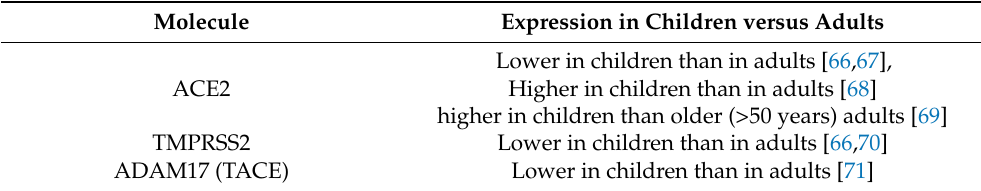
Figure 2. Expression of molecular and immunological determinants related to viral entry and disease outcome in COVID-19 in children and adults. MIS-C: Multisystem Inflammatory Syndrome in Children. Airway epithelium was depicted containing ciliated cells (brown), goblet cell (green), basal cells (pink), and club cells (blue). Image was created with Biorender.com (accessed on 14 February 2023). Table 1. Expression of molecular determinants related to viral entry in COVID-19 in children and adults.